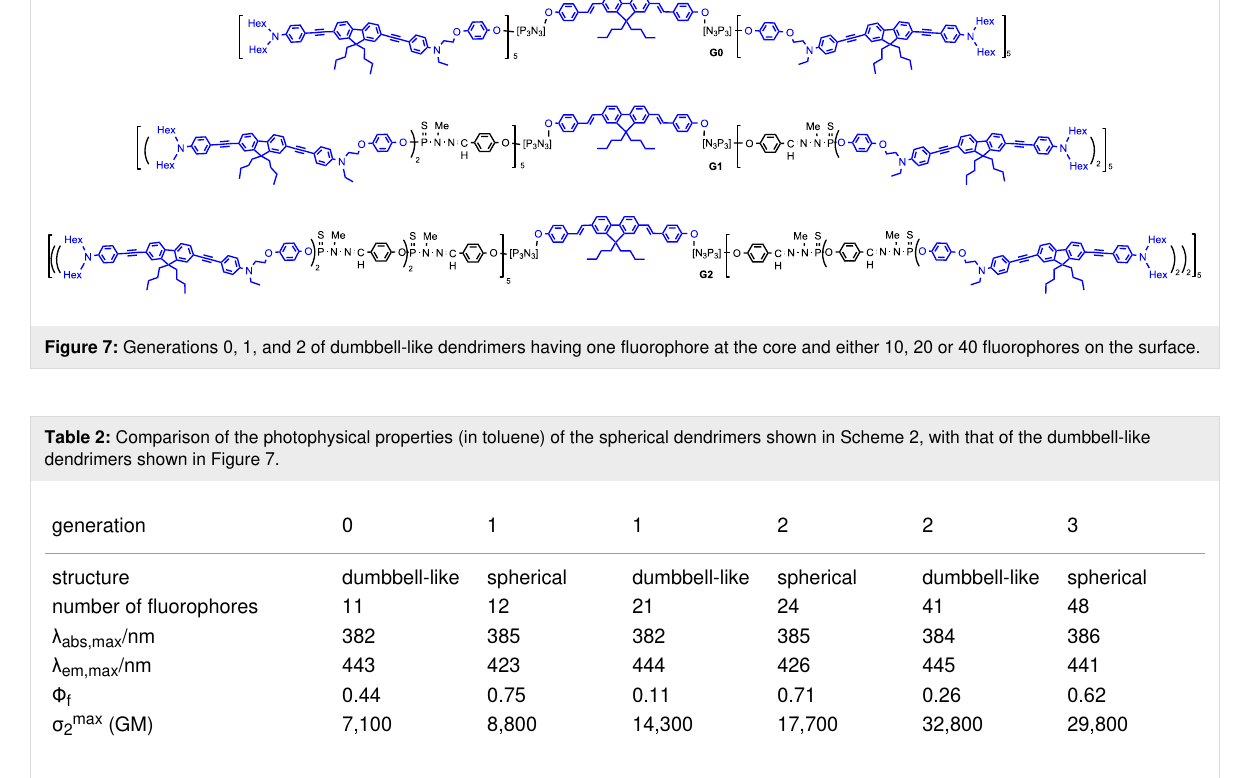
and packing of the fluorophores